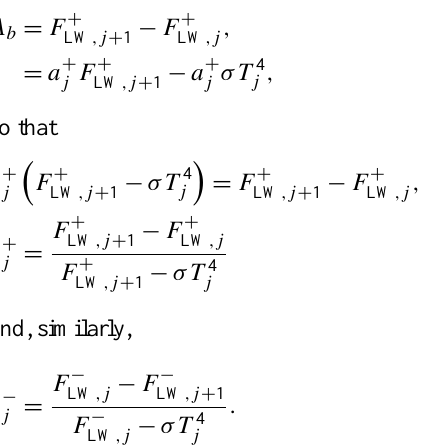
A1 Diagnosing absorptivity The absorptivity is diagnosed as follows. The absorbed radi-